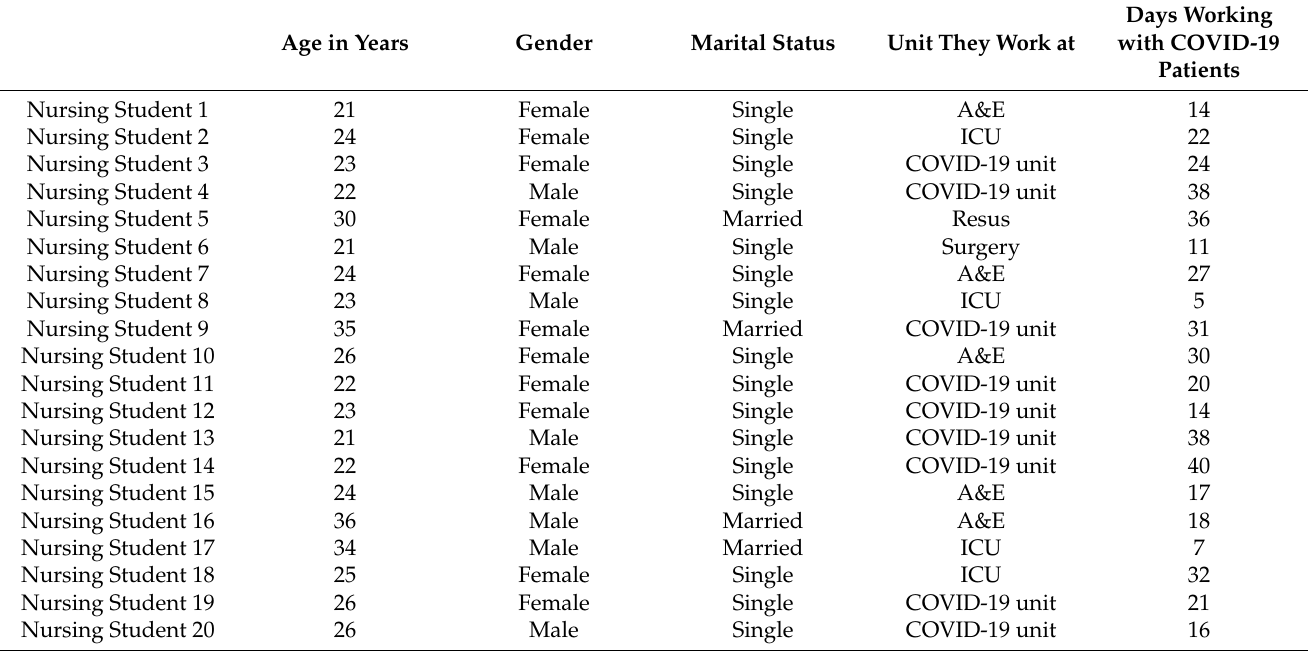
Table 2. Participants Characteristics.